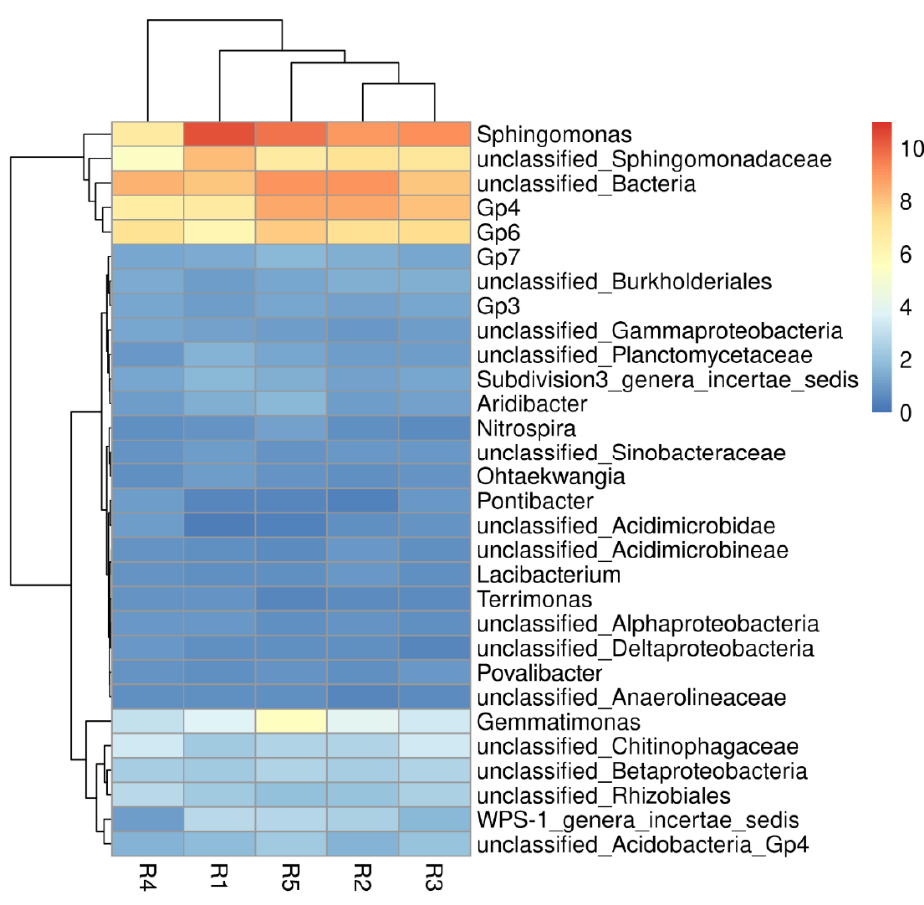
Figure 4. Microbial community heatmap and cluster analysis of the bacterial community composition in genus level. R1, R2, R3, R4, and R5 represent planting years for 1, 2, 3, 4, and 5 years, respec- tively.